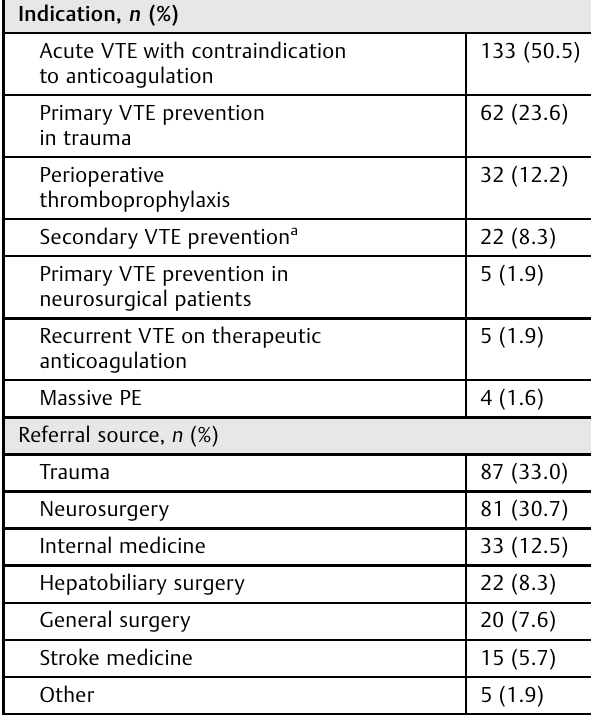
Table 1 Summary of indications for IVC fi lter placement and